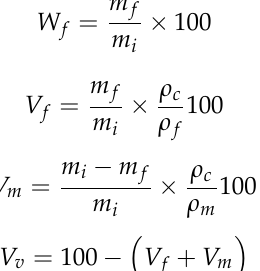
Table 1. The physical properties of the GF/mPPO masterbatch and composites.